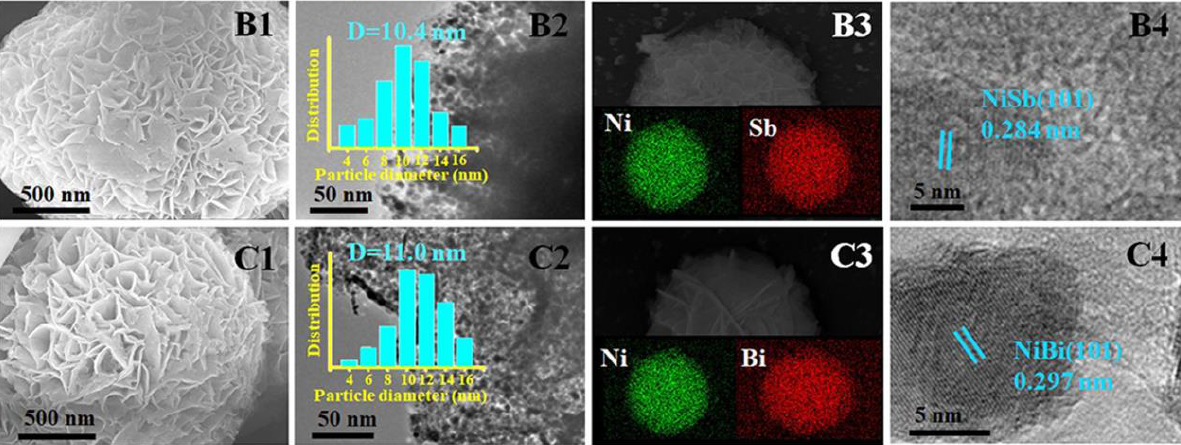
Figure 2. ( B1 ) SEM, ( B2 ) TEM and particle size distribution, ( B3 ) elemental mapping, and ( B4 ) lattice spacing images of NiSb IMC; ( C1 ) SEM, ( C2 ) TEM and particle size distribution, ( C3 ) elemental mapping, and ( C4 ) lattice spacing images of NiBi IMC [43]. (Copyright 2020, Elsevier).